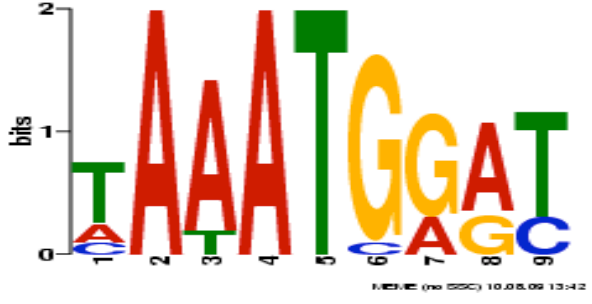
Figure 6. Logo of highest-scoring motif in hits and late gene upstream regions. E-value of 6.8 x 10 -1 and 15 occurrences in four upstream regions and six different